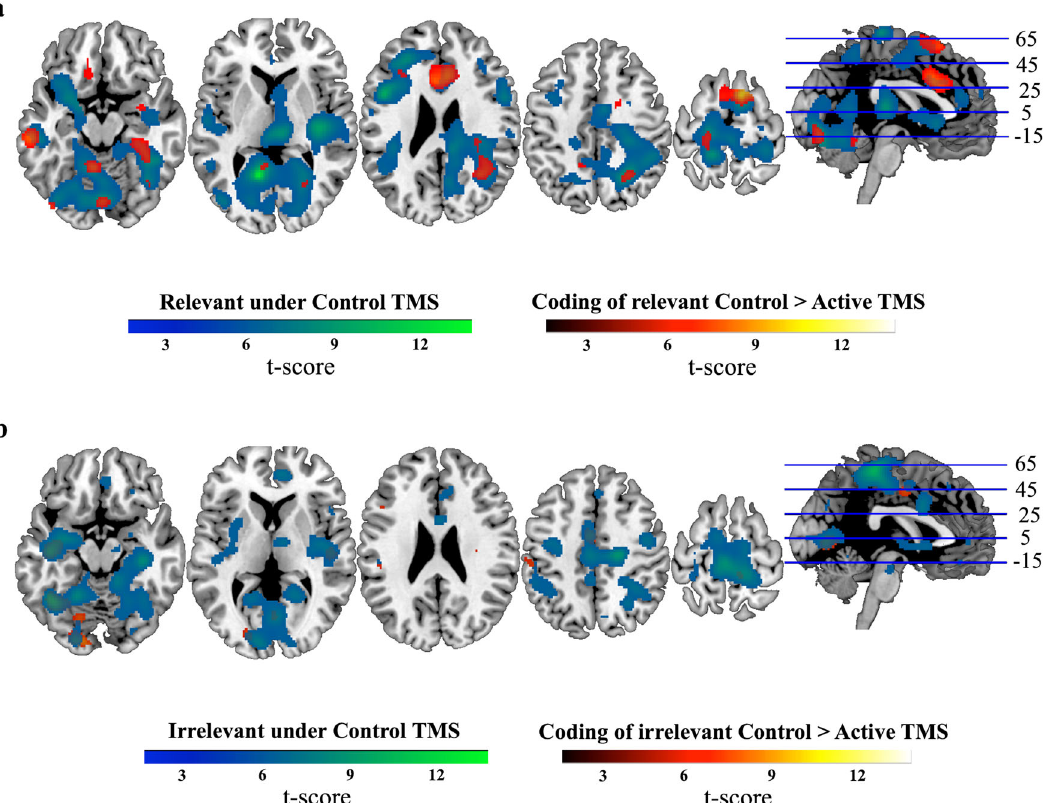
Fig. 7 Coding of relevant and irrelevant information assessed with a roaming searchlight. Whole-brain maps indicate where patterns of activation in the local neighbourhood (10-mm sphere) discriminated relevant information ( a ) or irrelevant information ( b ) under Control TMS (blue – green), and where coding was signi fi cantly reduced from Control to Active TMS (red – yellow). No other contrasts showed signi fi cant clusters and are not depicted. The results were thresholded at P < 0.0001 (FWE correction at the cluster level, P < 0.05). Coordinates of peak decoding are given in Supplementary Tables 2 and 3. N = 20 participants. Axial slices are depicted in neurological convention (i.e., the left hemisphere is on the left-hand side of the